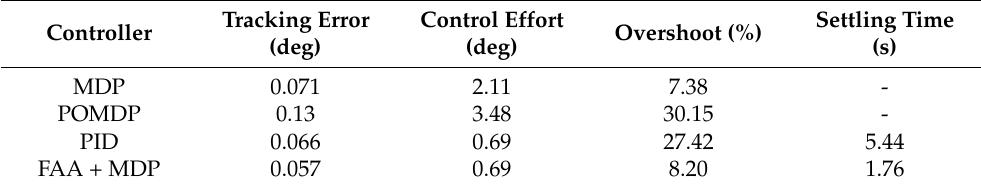
Table 6. Tracking error and control effort of four methods for θ des = 1 ◦